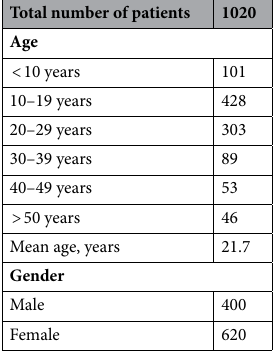
Table 1. Characteristics of subject.